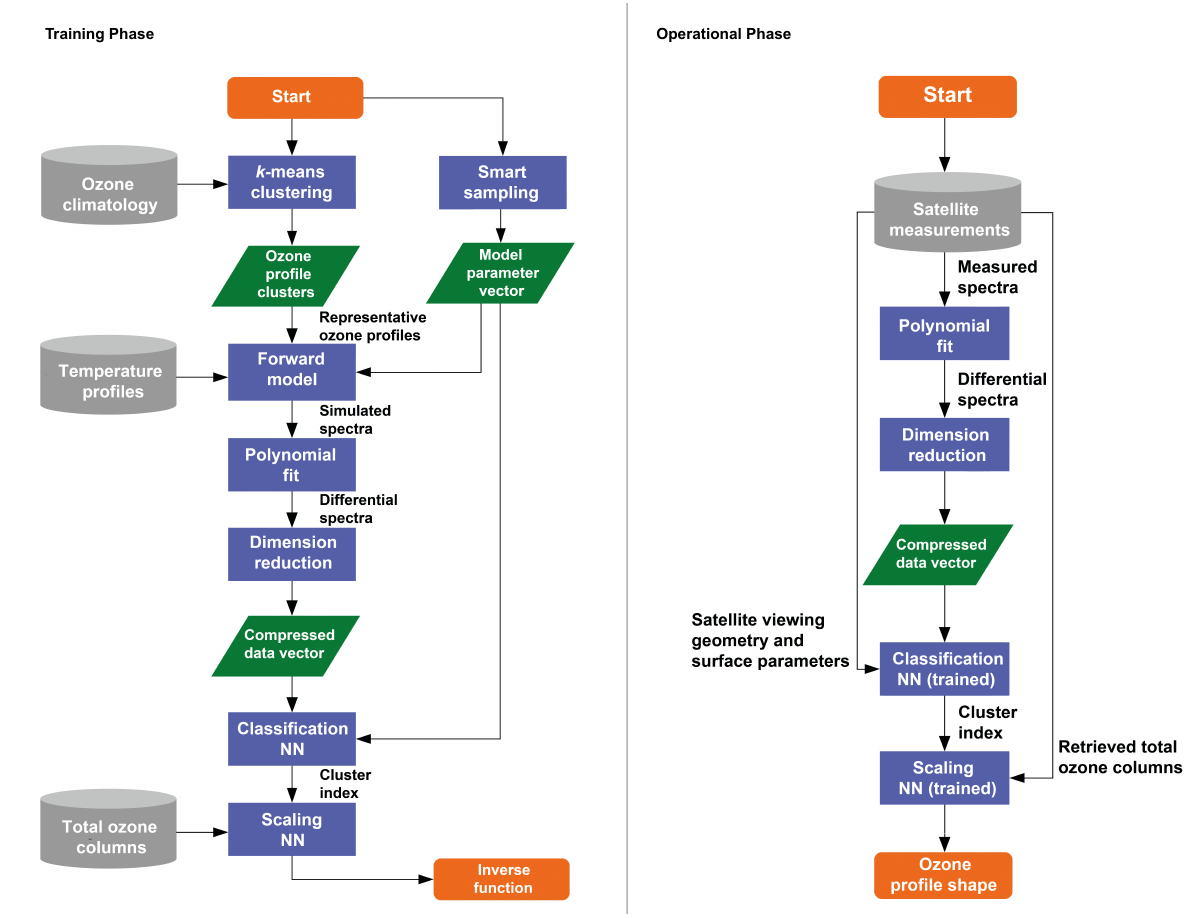
Figure 1. Diagram of FP-ILM for estimating O 3 profile shapes from satellite measurements (Xu et al., 2017, Fig. 1). NN stands for a neural